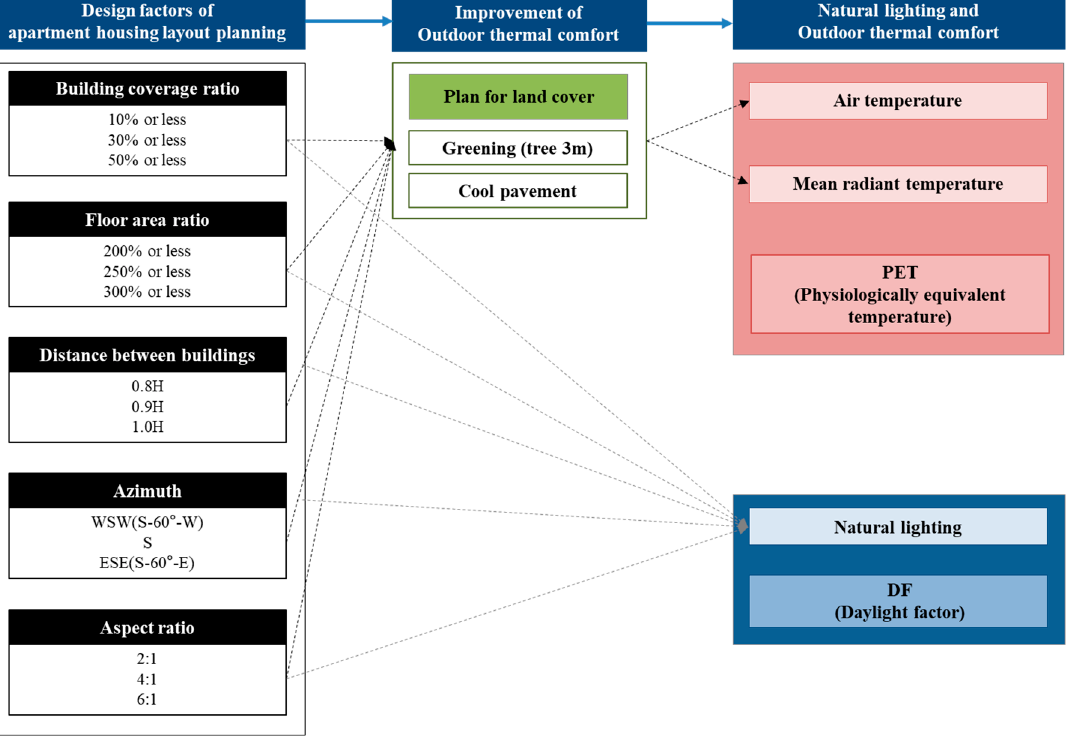
Figure 1. Matrix for securing natural lighting and improving outdoor thermal comfort.